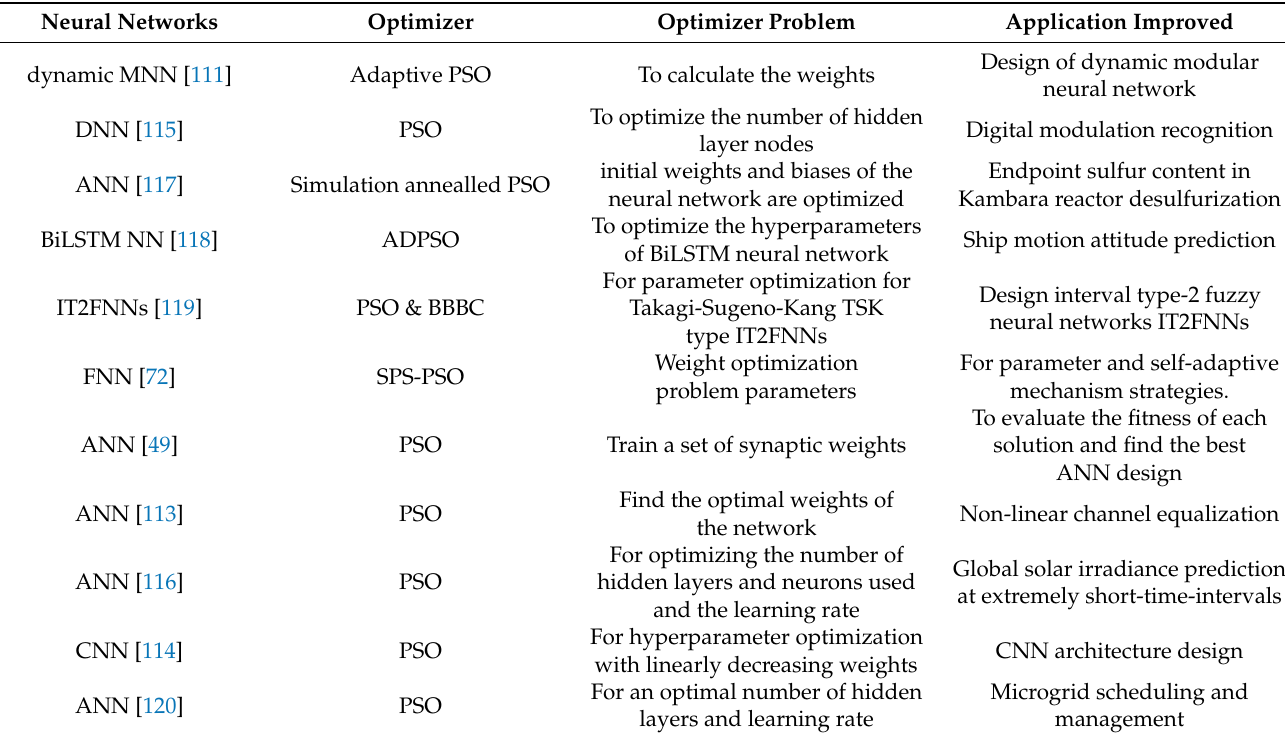
Table 2. Studies involving PSO for neural network design based on weights and neuron number optimization. Neural Networks